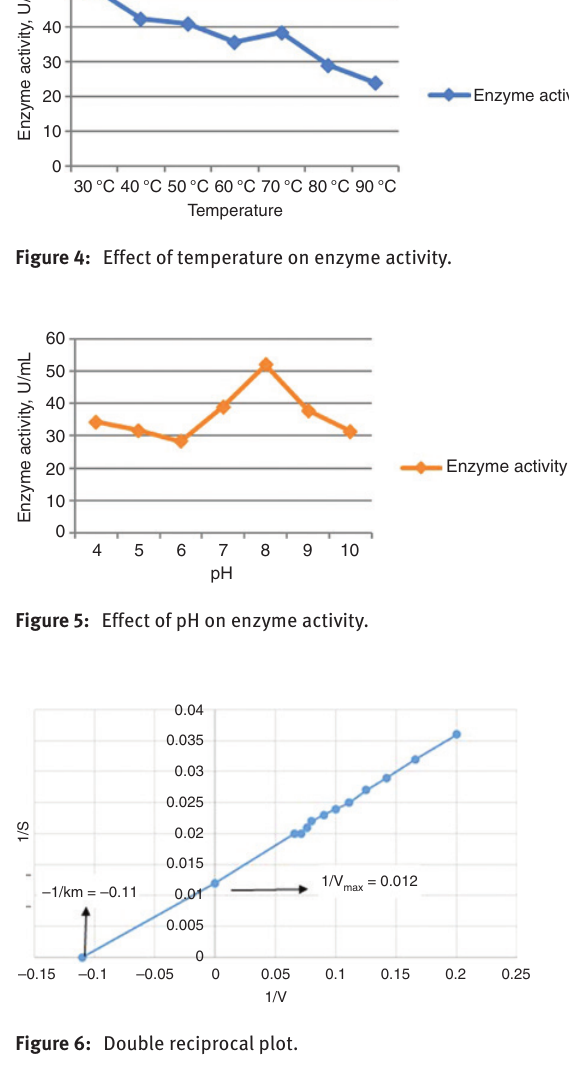
Figure 6: Double reciprocal